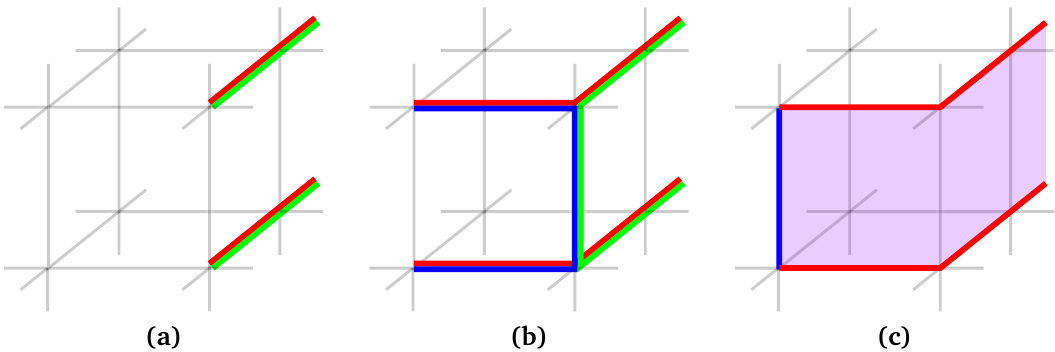
Figure 6: (a) A pair of displaced lineons at the two endpoints of the red / green strings. The pair of lineons is a planon, which can move along a two-dimensional plane. This is because, as shown in (b) , they can turn a corner (without leaving any excitations behind) by exchanging a blue / green lineon. (c) A string-membrane-net configuration that is equivalent to (b) and can be obtained from (b) by applying the string-membrane fluctuation operators in Eq. (21).